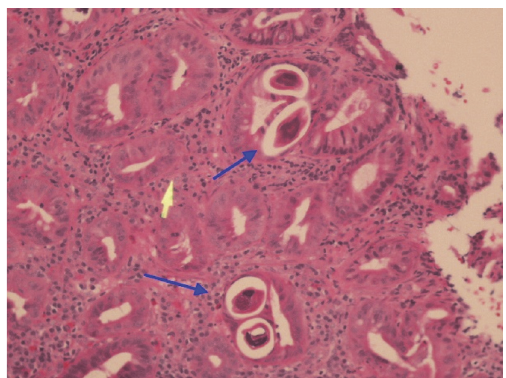
Figure 2: Haematoxylin and eosin (H&E) stain, gastric mucosa nonfundic type, and cross section view of Strongyloides stercoralis under 200x (blue